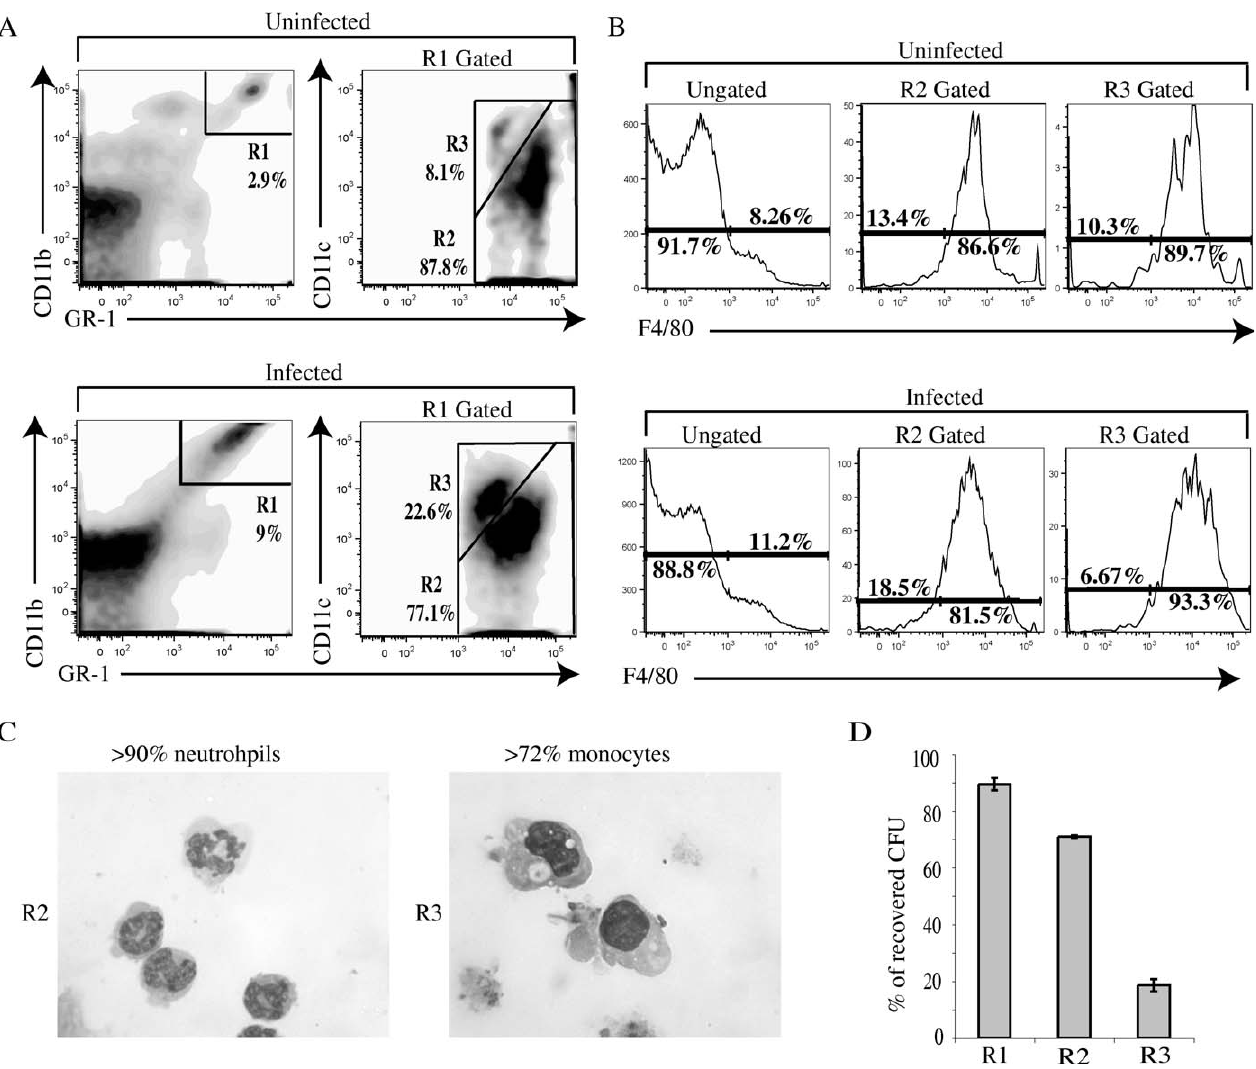
Figure 4. GR-1 þ /CD11b þ Cells Consist of Neutrophils and Monocytes FACS analysis was performed on spleen cells from uninfected C57BL/6 mice or mice infected with 14028 for 2 days (A). The level of GR-1 and CD11b in total viable spleen cells is shown in the density plots on the left. GR-1 þ /CD11b þ cells (R1 gate) were analyzed for CD11c and GR-1 expression levels in the density plots to the right. The level of F4/80 expression for ungated cells (all analyzed cells), R2 and R3 gated cells are shown in the histograms (B). GR-1 Hi/CD11c Lo (R2) cells and GR-1 Int/CD11c Hi (R3) cells from infected mice were FACS sorted, then cytospun onto slides, and stained with Wright- Giemsa stain and visualized by microscopy (C). 300 cells from Wright-Giemsa stained slides were analyzed and the percentage of neutrophils and monocytes was determined. The percentage of total intracellular Salmonella in GR-1 þ /CD11b þ cells was estimated (D). GR-1 þ /CD11b þ cells (R1), GR-1 Hi / CD11c Lo (R2), GR-1 Int / CD11c Hi (R3) populations were FACS sorted, lysed, then plated on LB to determine the number of intracellular CFU. The percentage of total recovered CFU was then calculated for each FACS sorted population (see Materials and Methods). The graph shows the average percentage total recovered CFU present in each FACS sorted population from three mice and the error bars represent one standard error of the mean.